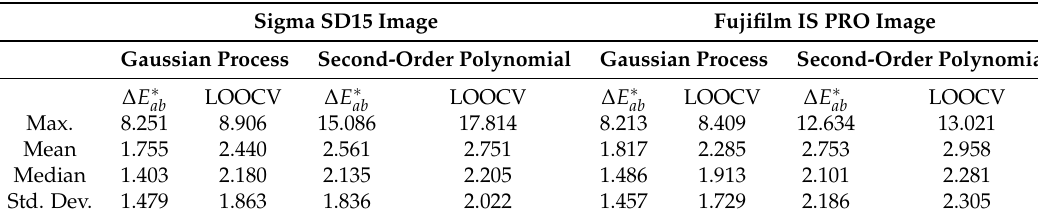
Table 2. ∆ E ∗ summary of the statistical results after the characterization. ab